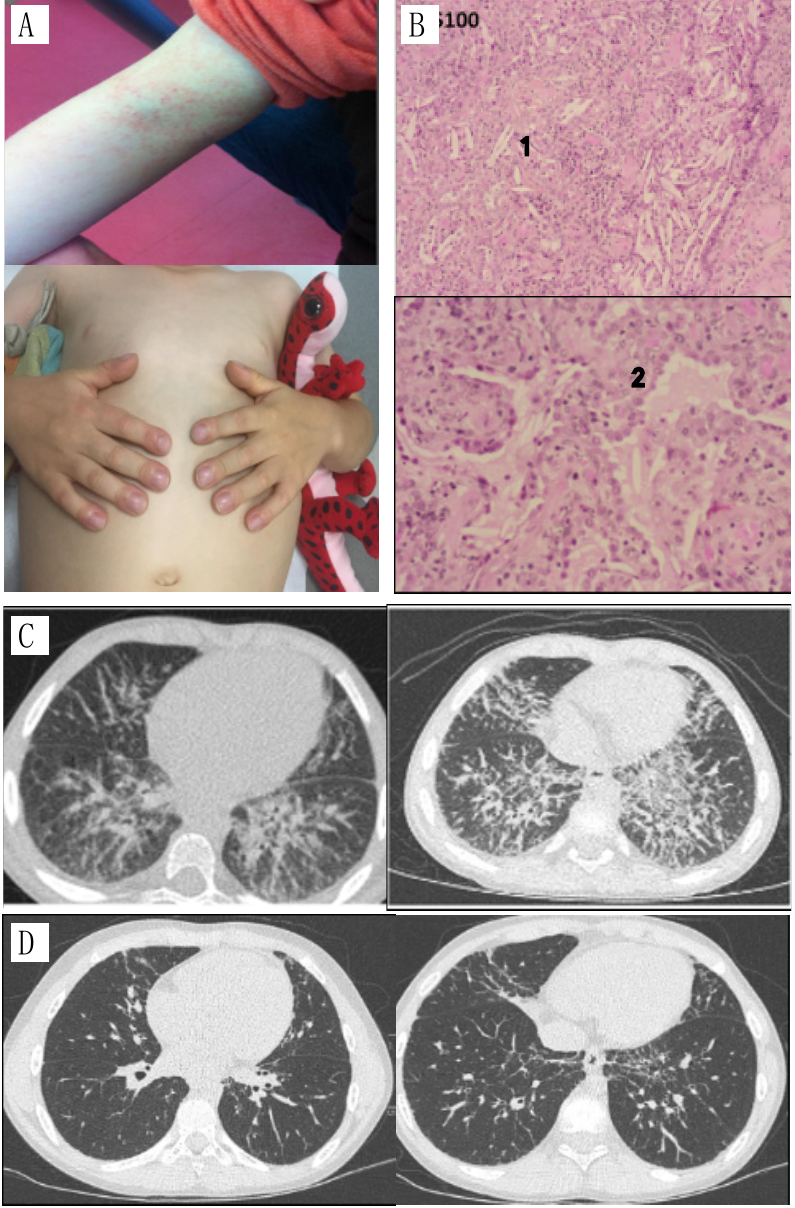
Figure 1. ( A ) specific rash and nail clubbing; ( B ) Lung biopsy, 1: parenchymal crystals, 2: foamy histiocytes; ( C ) CT, diffuse interstitial syndrome, predominantly in the two lower lobes with inter-lobular septa, peribronchovascular thickening and some peribronchovascular and subpleural micronodules. Increased diffuse interstitial syndrome, more extensive in the upper lobes and the anterior territories of the lower and middle lobes; ( D ) CT two years after introduction of baricitinib: significant improvement in bilateral interstitial lung disease.